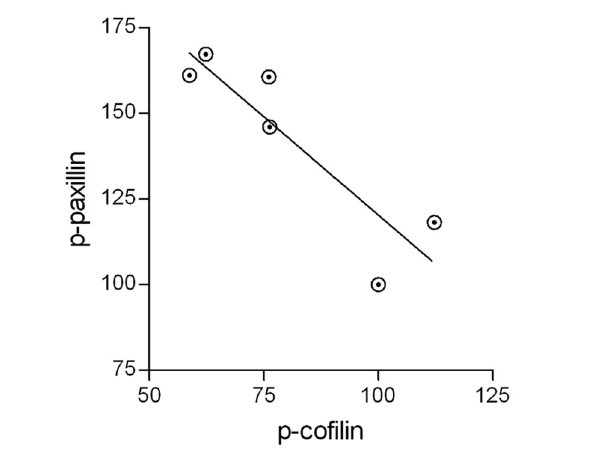
FIGURE 5 |The activation of paxillin and cofilin are linked. All values of active p-paxillin and inactive p-cofilin that are presented in Figures 3 and 4 were subjected to linear regression and correlation analysis.The two display a negative correlation with an r 2 value of 0.79. Significance of correlation by the Pearson double tailed test is p <